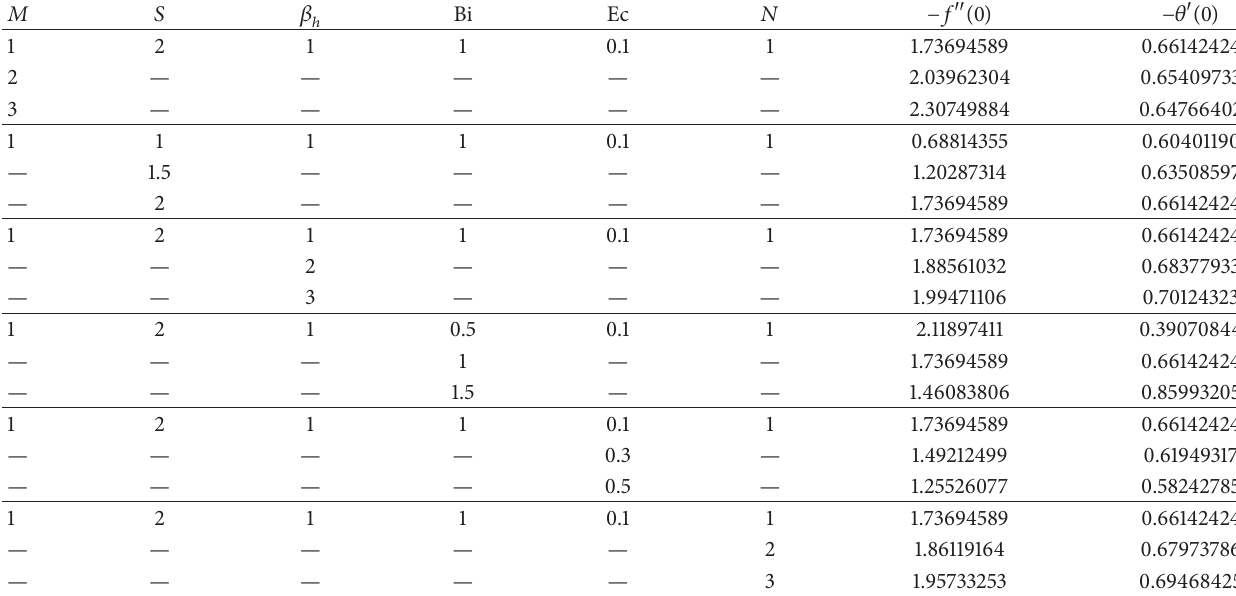
Table 3: Values of −𝑓 󸀠󸀠 (0) and −𝜃 󸀠 (0) for different values of the